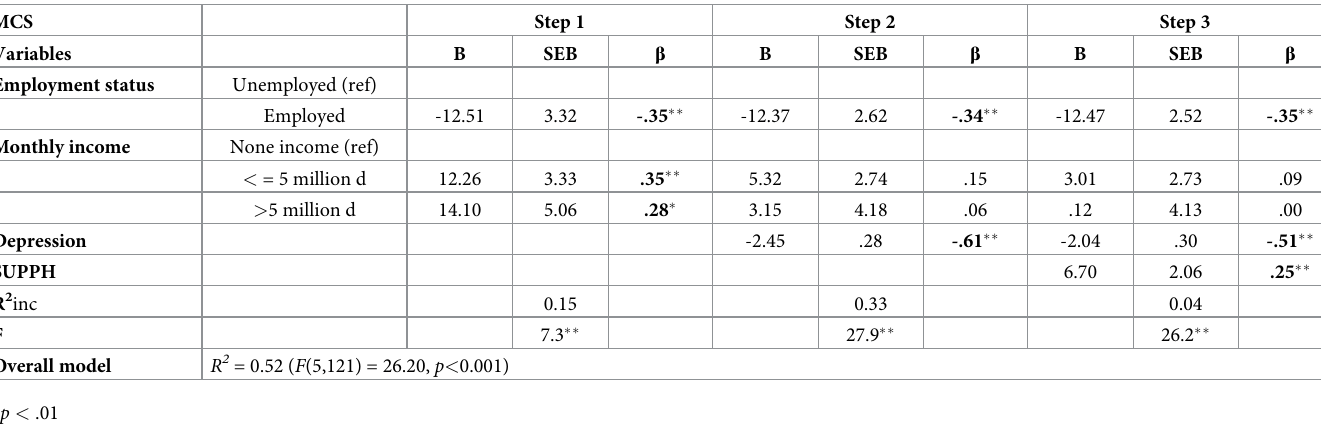
Table 6. Hierarchical regression of SUPPH scale, depression scale, and demographics predicting MCS ( n = 127).